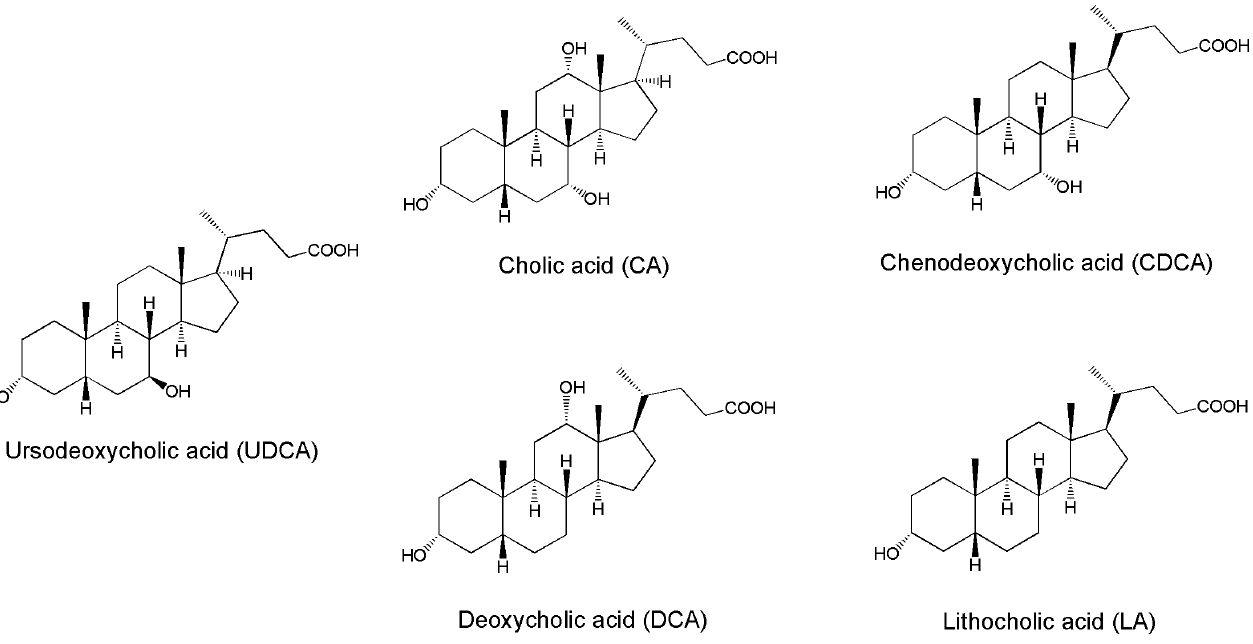
FIGURE 1 - Chemical Structure of Bile